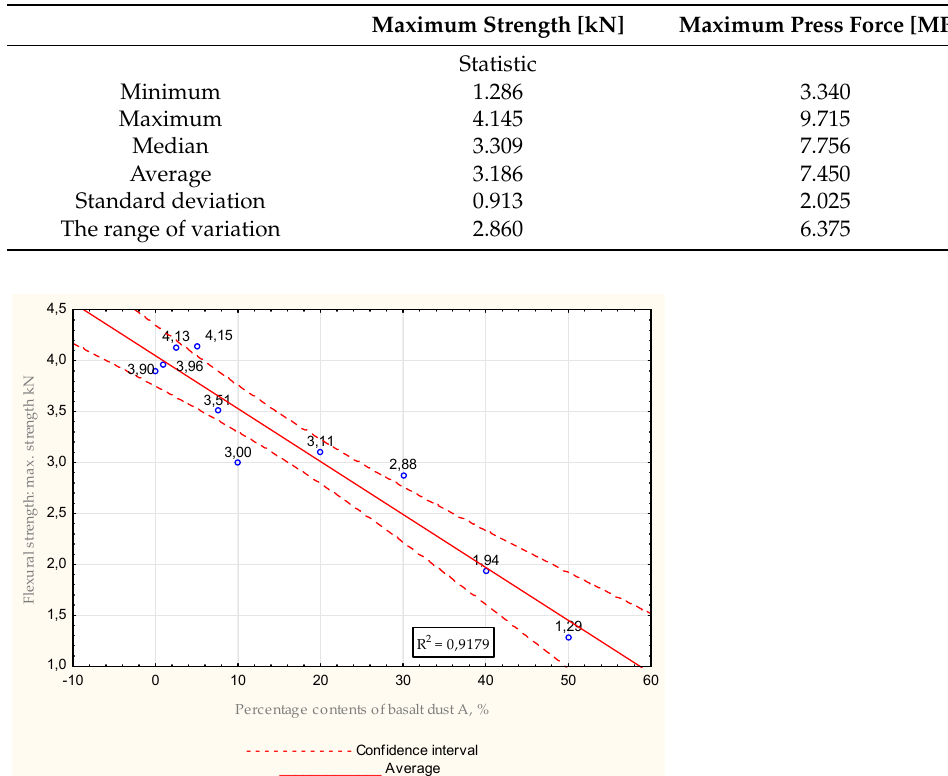
Energies 2022 , 15 , 7033 Figure 19. Average values received during flexural strength tests for water − mix ratio = 0.6, maximal strength.